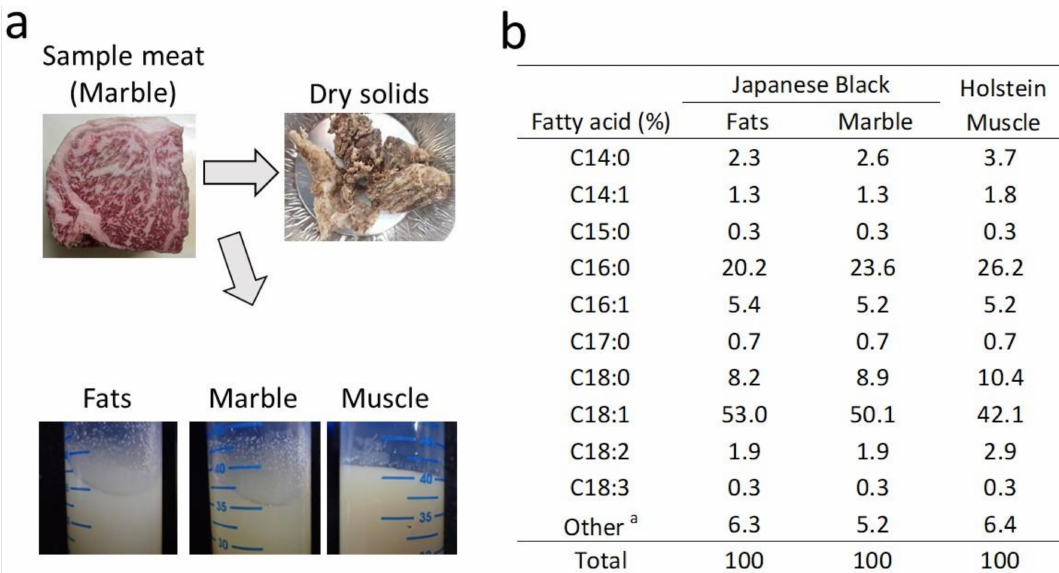
Figure 1. Comparison of low-temperature-vacuum-extracted beef tallow. ( a ) The images show the sample meat, beef tallow, and dry solids. The images above show the sample meat and dried solids derived from the marbling of the longissimus muscle of Japanese Black cattle. The images below show the surface condition of beef tallow after incubation at 30 ◦ C for 1 h. ( b ) The table shows the proportion of fatty acid in beef tallow collected by vacuum distillation. a Other indicates the total peak area of the unidentified molecular